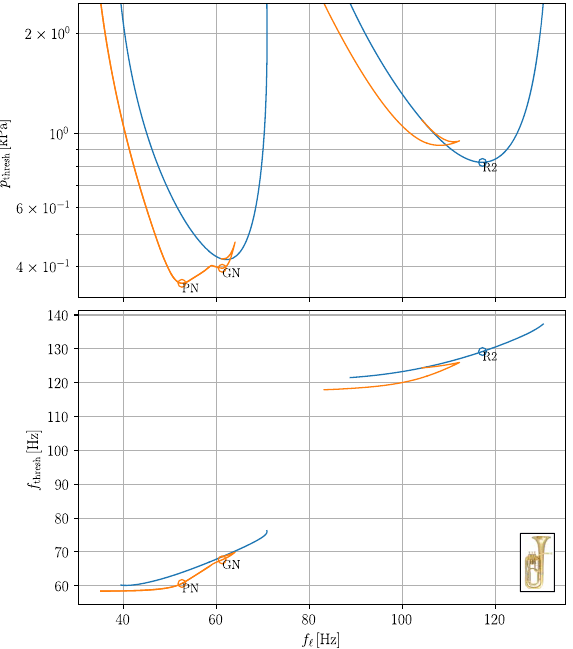
Figure 10. Top and bottom plots represent respectively the threshold pressures and threshold frequencies given by the locus of the Hopf points (blue) and the locus of the saddle-node bifurcation points (orange) with respect to the lips ’ resonance frequency in the case of the B [ -baritone saxhorn. The circles identify the local minimum of blowing pressure for each note, namely the pedal note (PN), the ghost note (GN), and the second regime (R2). In the case of the second Hopf bifurcation, the easiest note playable is given by the minimum of the Hopf points ’ locus (blue curve), as its minimal threshold mouth pressure is lower than the one given by the saddle-node bifurcation points ’ locus (orange curve). In the case of the fi rst Hopf bifurcation, the locus of the saddle-node bifurcation points (orange curve) shows two local minima, each one corresponding to the ghost note and the pedal note, as both these minima lie lower than the locus of the Hopf points and have a signi fi cantly different threshold frequency.